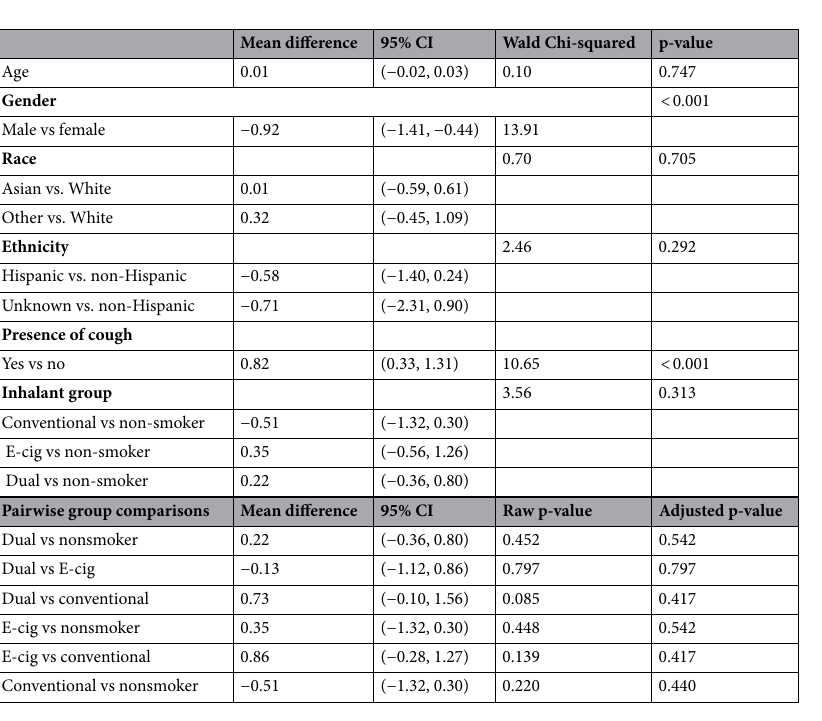
Table 3. Linear regression model to assess the association between inhalant groups and PSQI scores or sleep quality. This table shows the multivariable linear regression model with PSQI score as the outcome, inhalant groups, age, gender, race, ethnicity, and presence of cough as the predictors. The bottom table further shows the pairwise comparisons among inhalant groups with adjusted p-values using the method of Benjamini & Hochberg. PSQI is a tool to assess sleep quality and disturbances over a one-month interval; the self-rated questionnaire yields scores from 0 to 21 with higher scores indicating poorer sleep